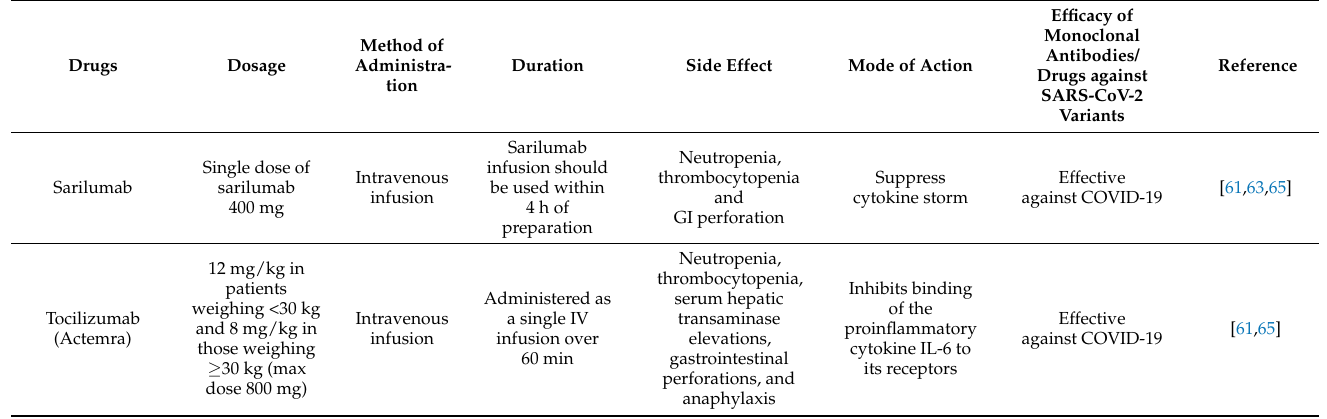
Table 2. List of drugs which has been approved and authorized by FDA for emergency use